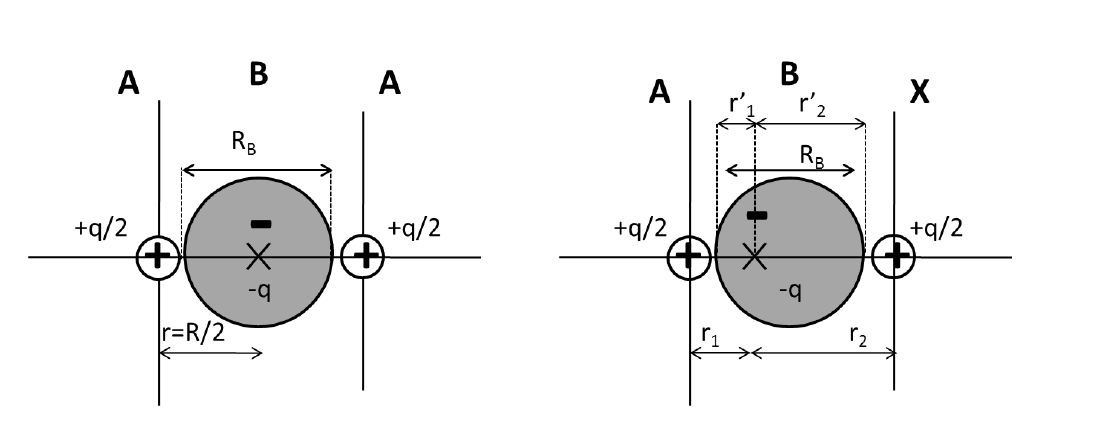
Figure 1. Bond charge model for homonuclear ( left ) and heteronuclear ( right ) molecules, A and AX , respectively. The meaning of the main parameters that are needed in each case 2 is shown in the figures: q and R R do for heteronuclear ones; B label stands for the bond (see text for more details). r ′ B r ′ are also shown for 2